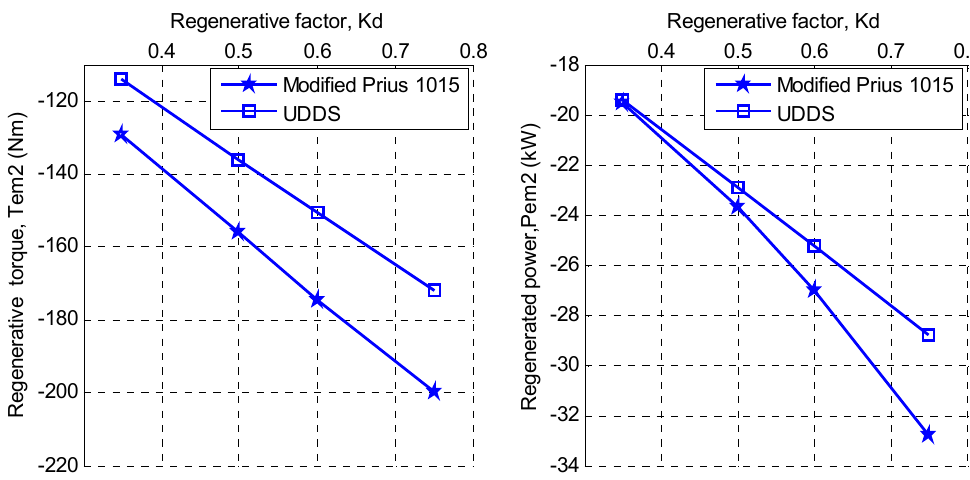
Figure 12. Effect of the regenerative factor on the power and torque of the